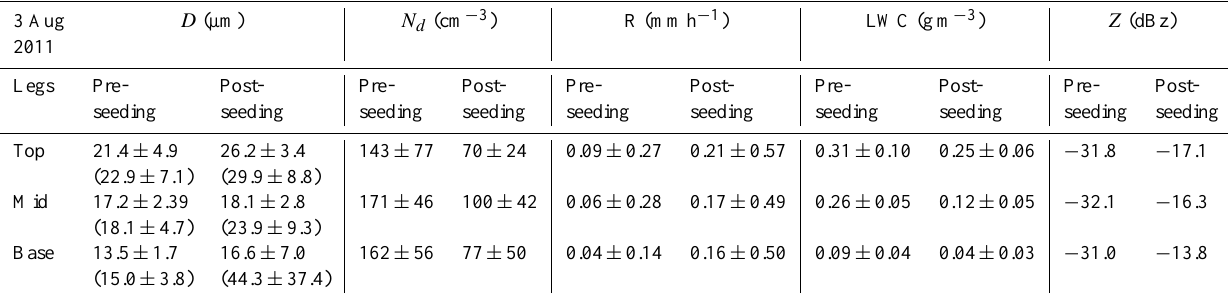
Figure 6. Changes in droplets’ (a) size, (b) number concentration, and (c) drizzle rate during cloud-base, mid-cloud and cloud-top legs on 3 August 2011. Data obtained from pre-seeding legs (1s values) are shown as grey (mean value as yellow square); data obtained from post-seeding flights are shown as red (mean value as blue square). Panels (b) and (c) are calculated from the drop size distribution (DSD) obtained from CAS and CIP probes, respectively. Panel (a) is calculated from DSDs obtained by combing the CAS and CIP probes. Table 3. The mean value of effective diameter D , number concentrations N d of cloud droplets, precipitation rate, R , and the median value of calculated radar reflectivity Z on 3 August 2011 for pre- and post-seeding legs at cloud-top, mid-cloud and cloud-base heights. D shown in the parentheses is calculated from drop size distributions obtained by combining the CAS and CIP